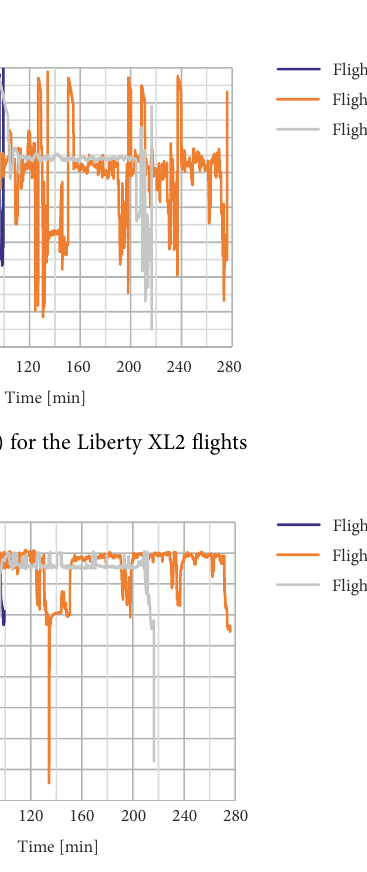
Figure 4. Mean head temperature (a) and mean exhaust gas temperature (b) for the Liberty XL2